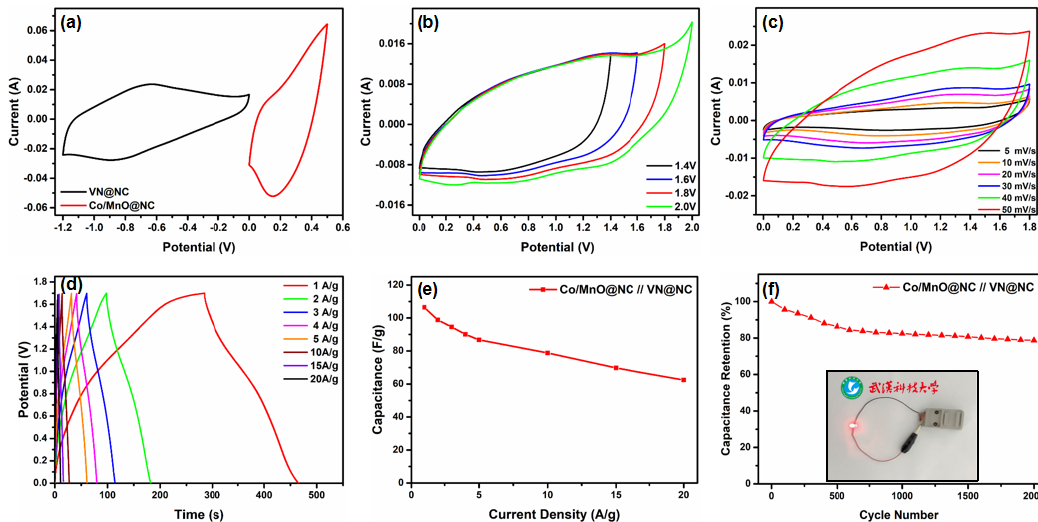
Figure 6. Electrochemical performance of the asymmetric supercapacitor (ASC) device assembled with Co/MnO@NC//VN@NC: ( a ) CV curves of the two electrodes at a scanning rate of 50 mV s − 1 ; ( b ) CV curves in different potential ranges; ( c ) CV curves at different scanning rates; ( d ) GCD curves; ( e ) specific capacitances; ( f ) cycling performance at 10 A g − 1 .